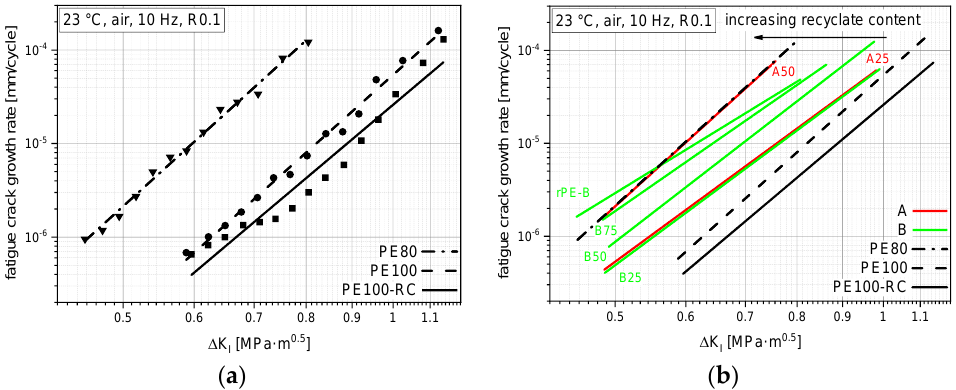
Figure 7. FCG kinetic curves of the three virgin benchmarks ( a ) and of all tested materials including compounds ( b ). rPE-A and A75 did not show any measurable crack growth until failure and therefore are not depicted.